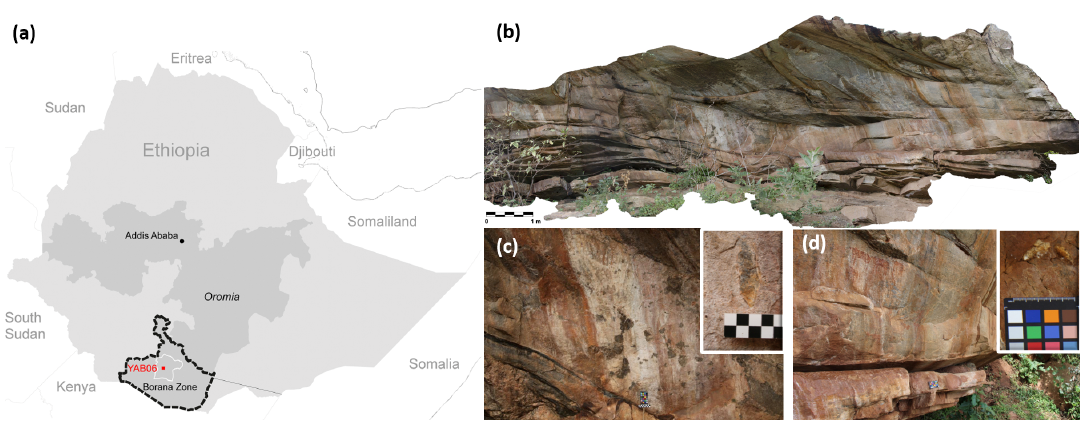
Figure 1. ( a ) Position of the Yabelo site; ( b ) overview of the rock art gallery of YAB6; ( c ) sample 1 was taken from white colored coatings close to the middle of the gallery; ( d ) sample 2 was taken from red colored coatings at the lower right.